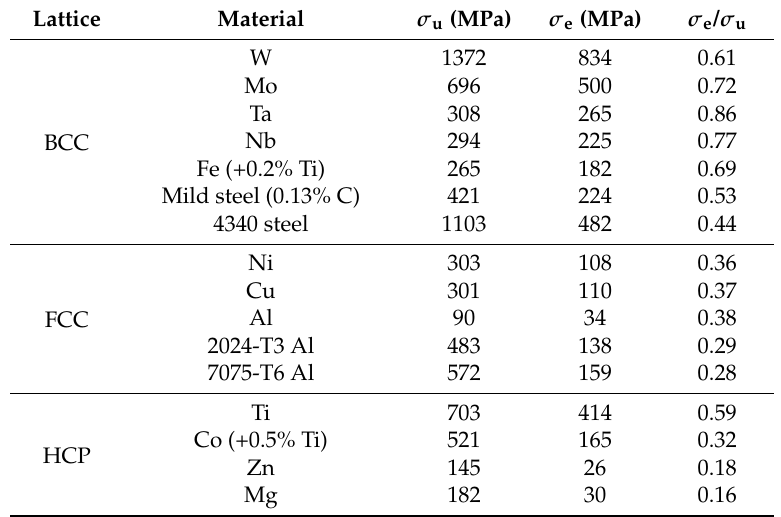
Table 1. Fatigue ratios for a number of materials in the various crystal systems, data from [5]. Lattice